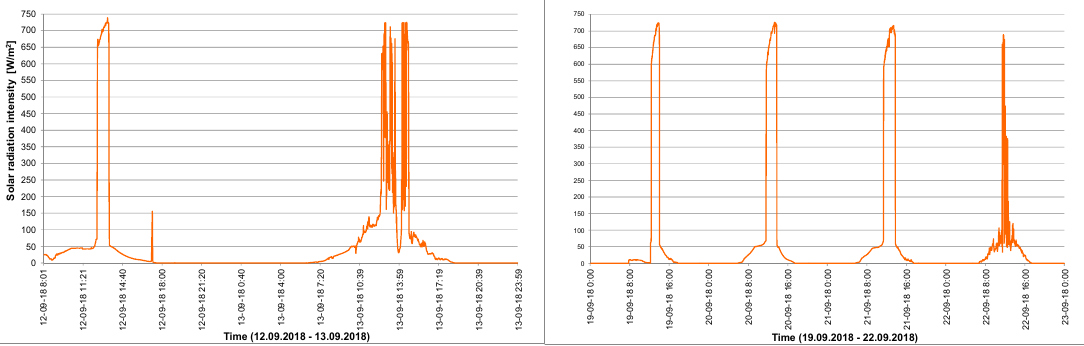
Figure 6. Distribution of solar radiation intensity.